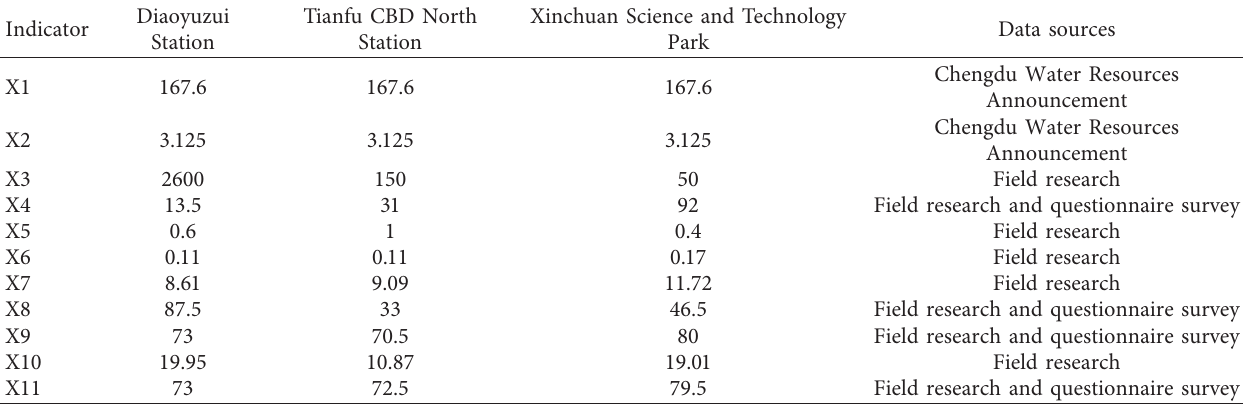
Table 2: Indicators’ scores of three evaluation objects.